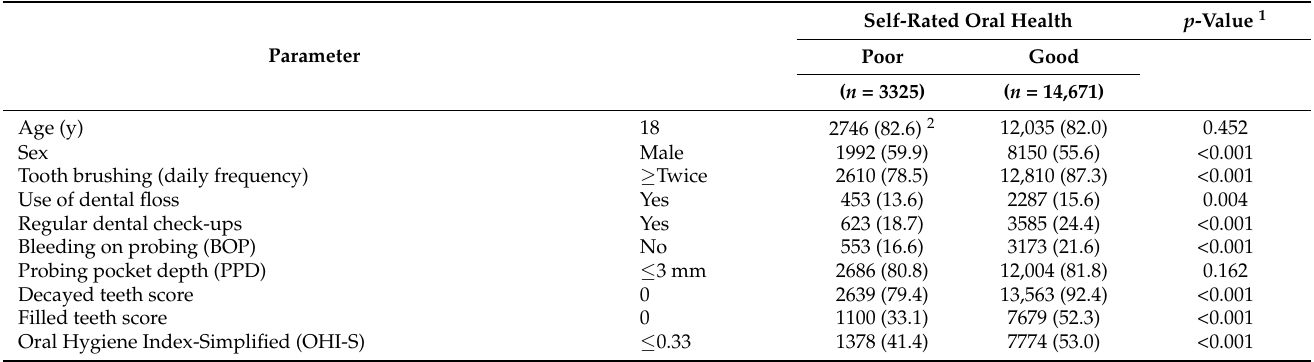
Table 2. Differences in age, sex, oral health behaviors, and oral status by self-rated oral health group, Japanese university students,